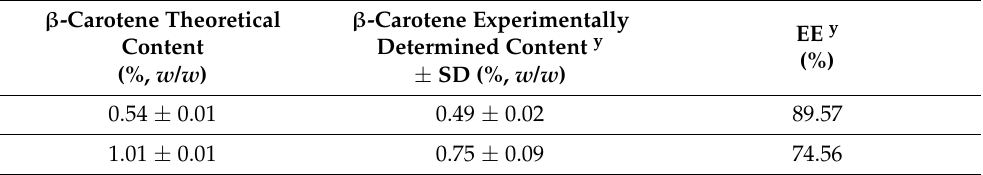
Table 7. β -carotene content and encapsulation efficiency of loaded SLN. β -Carotene